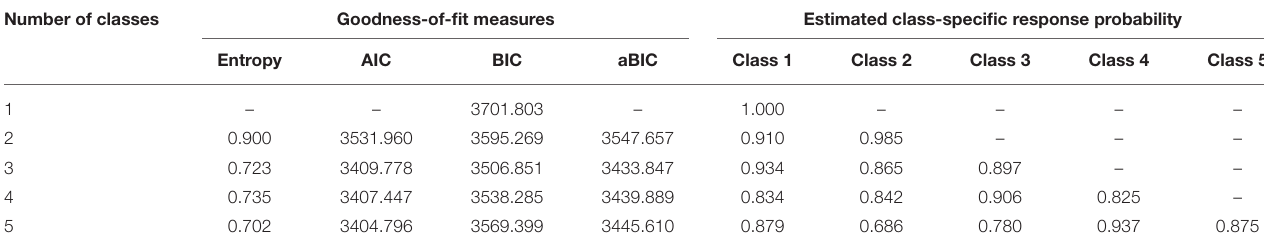
TABLE 2 | Goodness-of-fit-measures and class-specific response probabilities of the five investigated models for deciding the number of classes ( n = 503). Number of classes